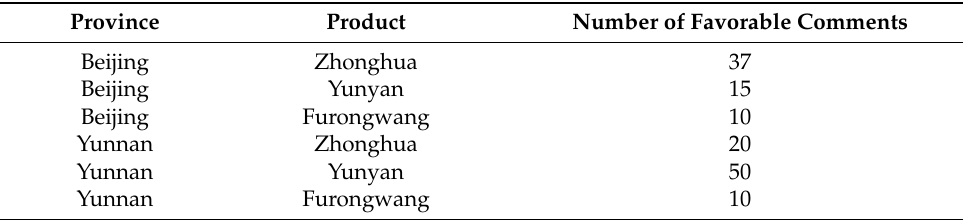
Table 3. The evaluation data of cigarette consumers.